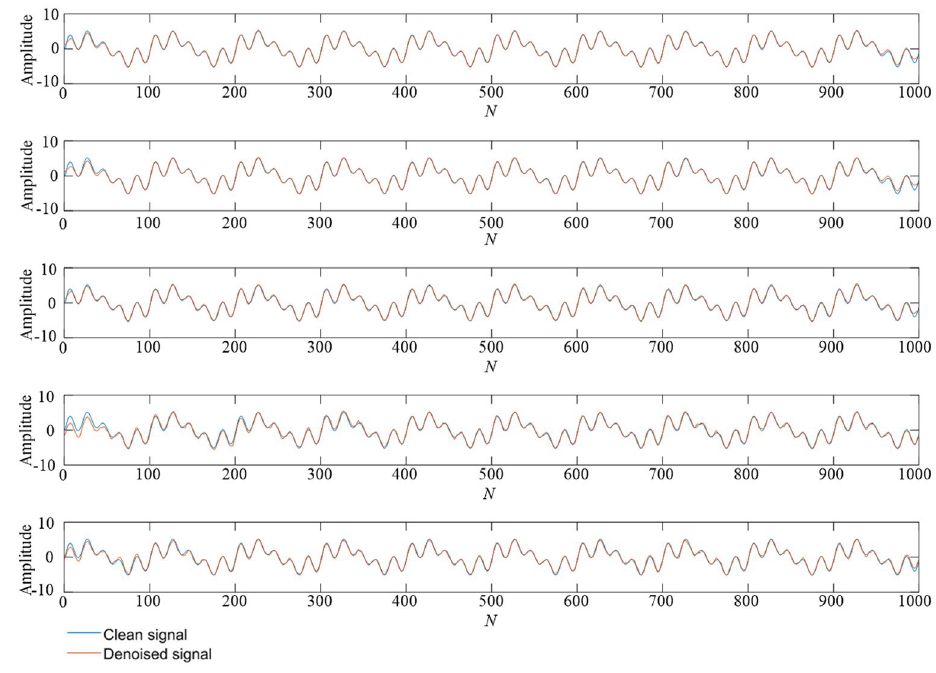
Figure 9. A comparison of denoising effect under 10 dB. From top to bottom: ( 1 ) TS-WOA-VMD-CA-WT; ( 2 ) WOA-VMD-CA-WT; ( 3 ) TS-VMD-CA-WT; ( 4 ) EMD-CA-WT; ( 5 ) EEMD-CA-WT.